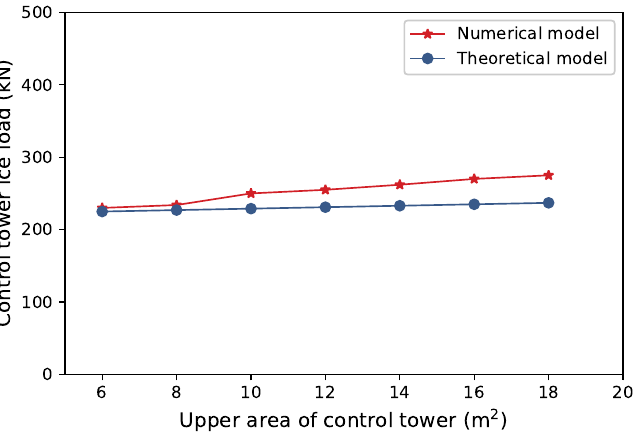
Figure 7. The relationship between the ice load of the command tower and its upper